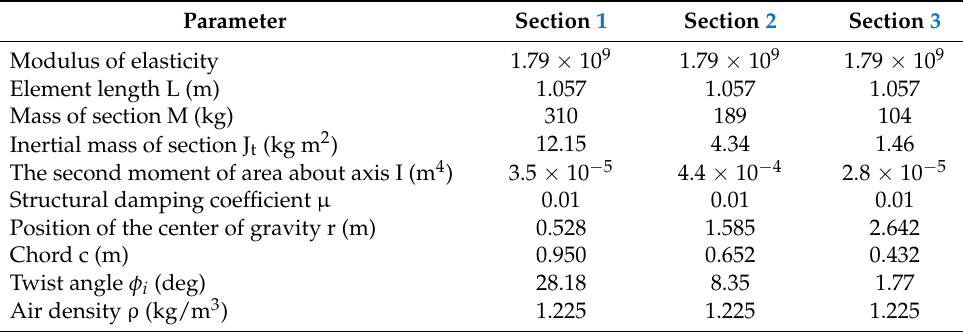
Table 3. Input parameters of the modeled blade (Ziway